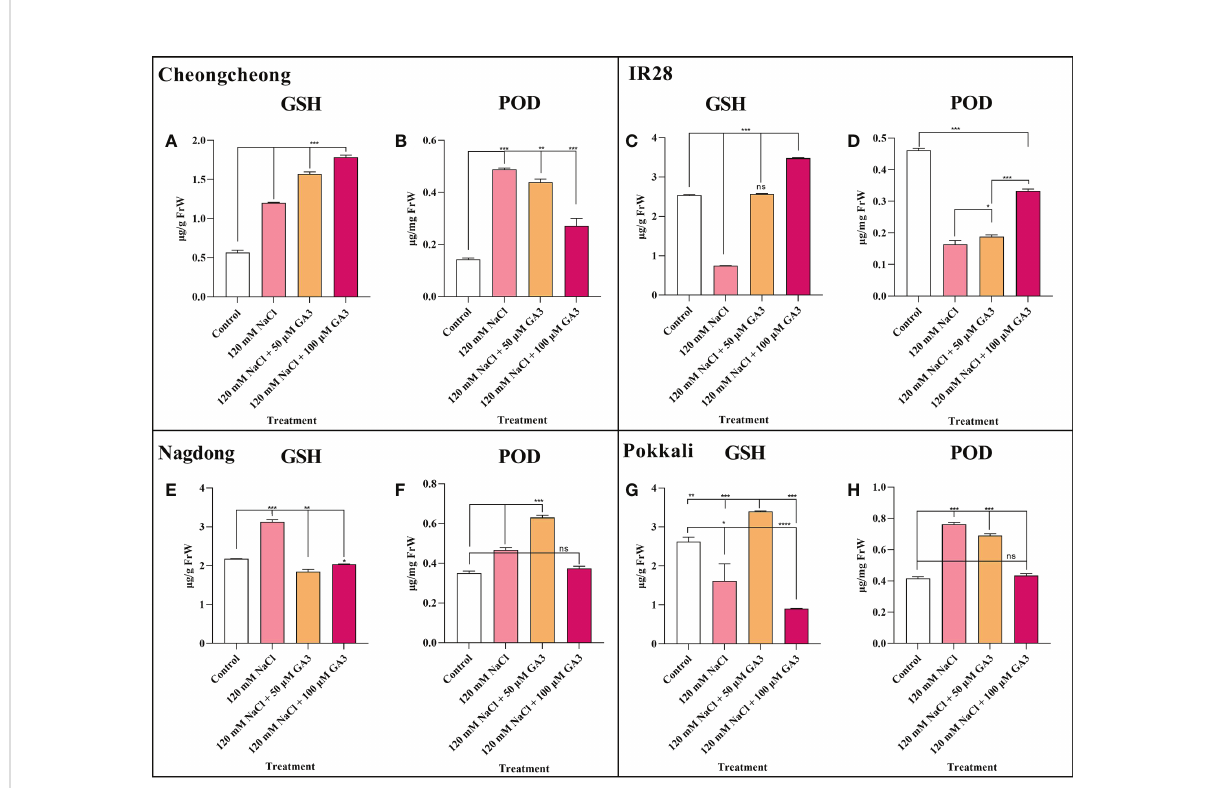
FIGURE 6 Effects of salt stress and exogenous GA3 application on antioxidant activity in rice ( Oryza sativa L.) seedlings (A – H) . Antioxidant activity in 14- day-old rice seedlings treated with distilled water (control), 120 mM NaCl, or 120 mM NaCl + 50 or 100 µM GA3. Group differences were analysed by one-way ANOVA. Asterisks indicate a signi fi cant difference compared to control, analysed by Tukey ’ s multiple comparison test. * P < 0.05, ** P < 0.01, *** P < 0.00; ns, not signi fi cant. FrW, frozen weight; GA3, gibberellic acid; GSH, glutathione; POD,